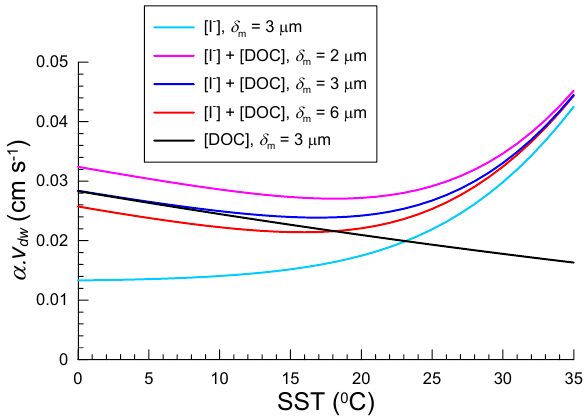
Figure 6. Variation in the oceanic component of ozone dry depo- sition velocity multiplied by ozone solubility, αv dw ( = 1 /r c ) , as a function of sea surface temperature. Curves determined using the present two-layer deposition scheme incorporating the ozone reac- tion with iodide [ I − ] , dissolved organic carbon [DOC], and the two reactions together ( [ I − ]+ [DOC]). The waterside friction velocity ( u ∗ w ) used was 0.01ms − 1